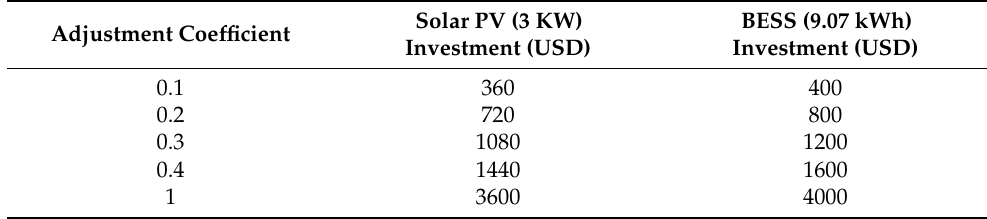
Table 16. Adjustment coefficient of the investments.